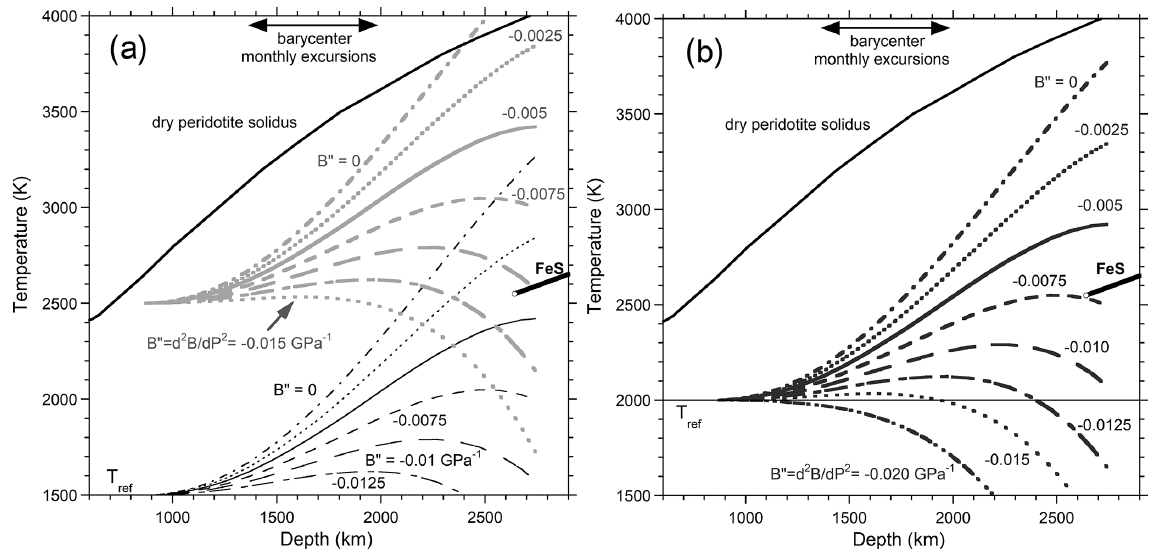
Figure 8. Families of geotherms for possible values of second P derivatives of LM bulk modulus and three different starting temperatures at 871km. All curves use the T derivative of B for silicate perovskite from Aizawa et al. (2004). For the dry peridotite solidus, results of Zhang and Herzberg (1994) are merged with high P data or Fiquet (2010). The thick black line is the eutectic melting curve of the Fe–S system (e.g., Morard et al., 2017).